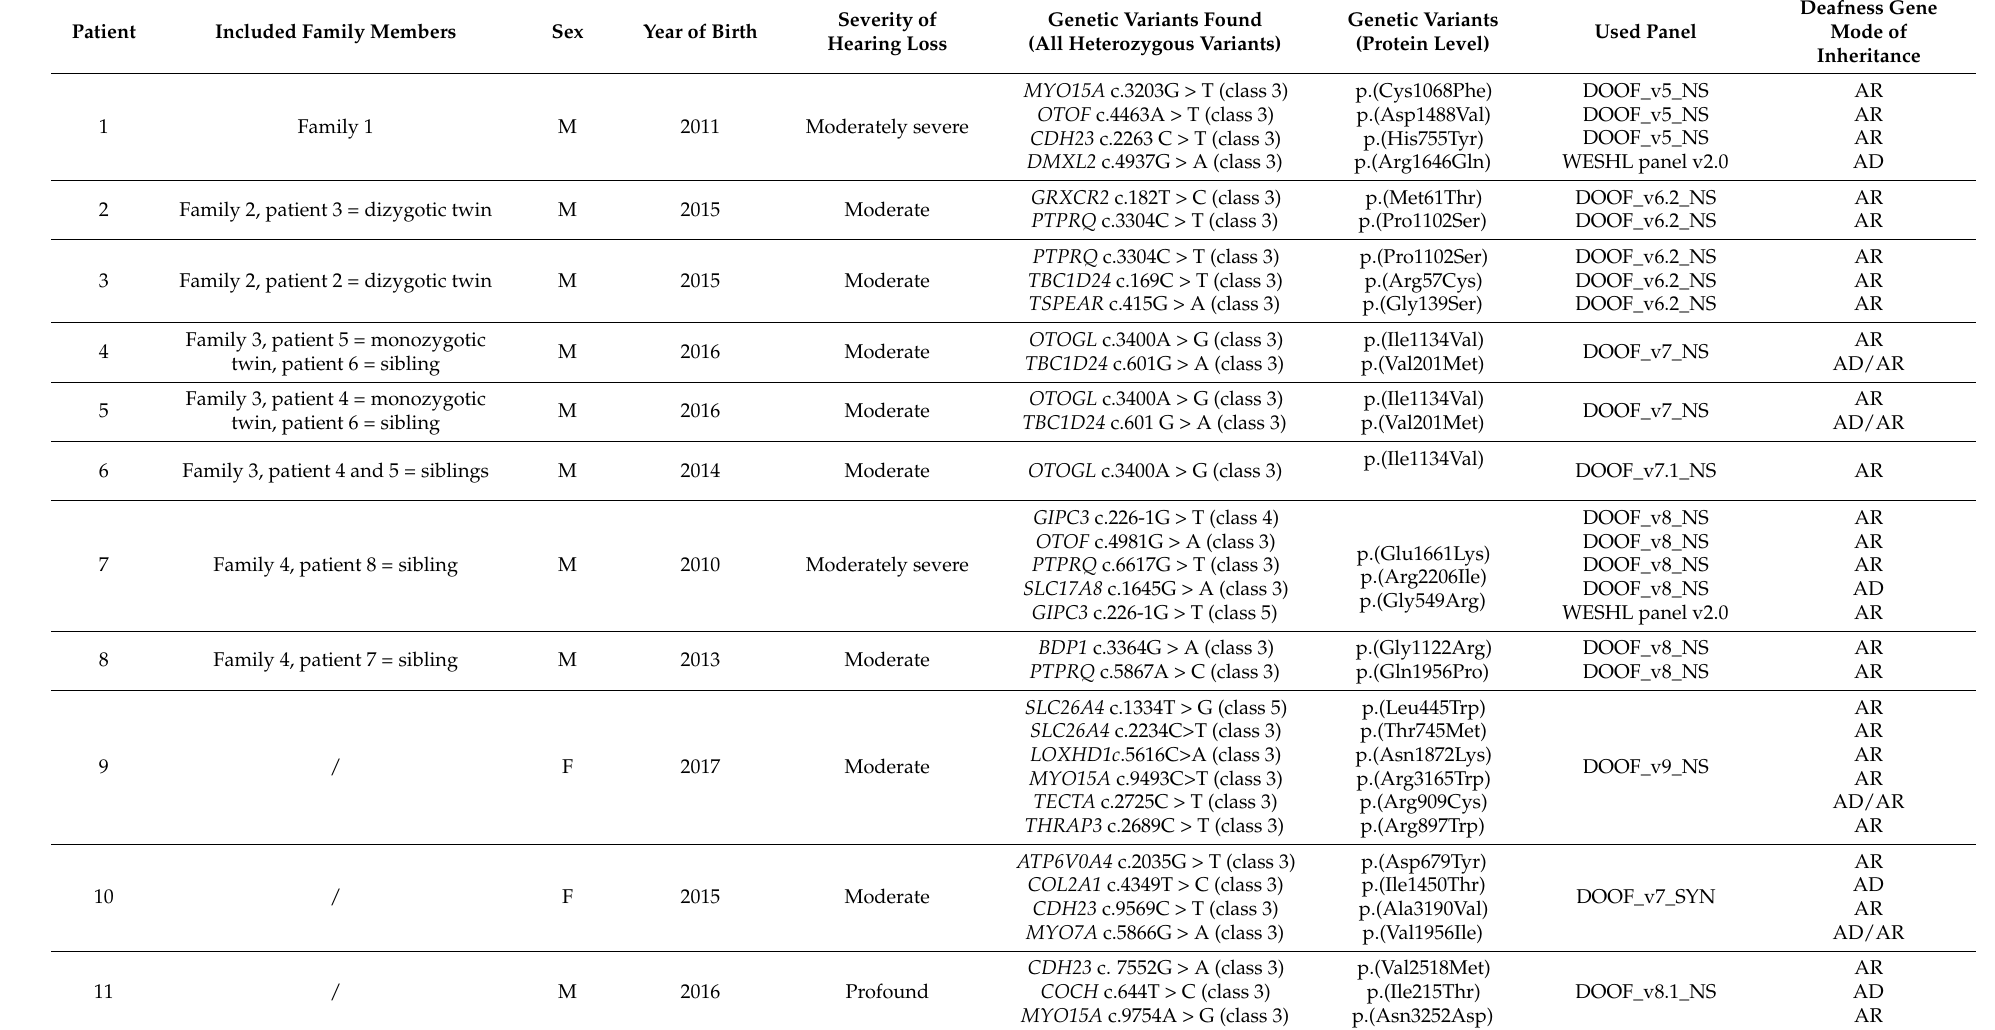
Table A2. Phenotypic and genotypic data of the included patients (AD = autosomal dominant, AR = autosomal recessive, F = female, M =